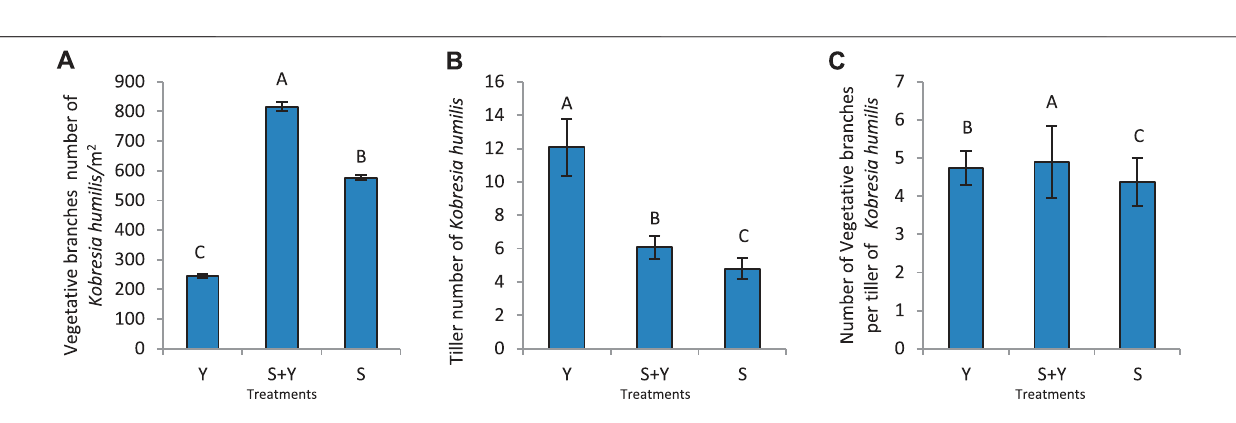
FIGURE 7 | Effects of grazing methods on vegetative reproduction of K. humilis in terms of (A) nutrient branch density, (B) number of tillers per plant, and (C) number of nutrient branches per tiller. Capital letters indicate signi fi cant differences ( p < 0.05) among grazing methods.